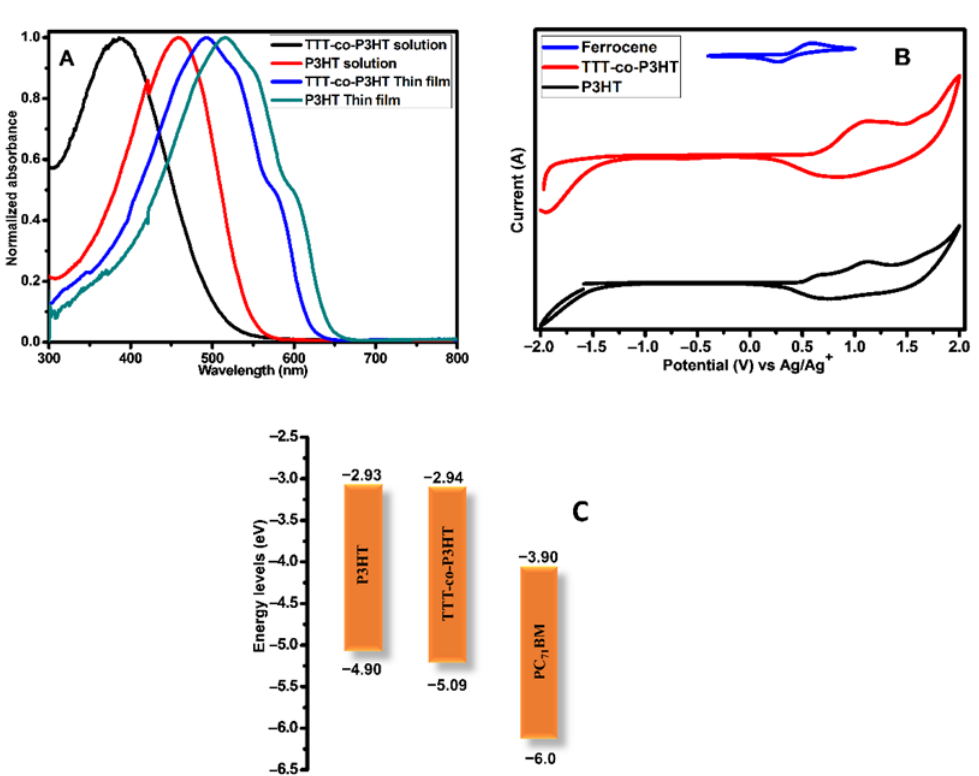
Figure 2. FTIR of P3HT, TTT-co-P3HT, and TTT.